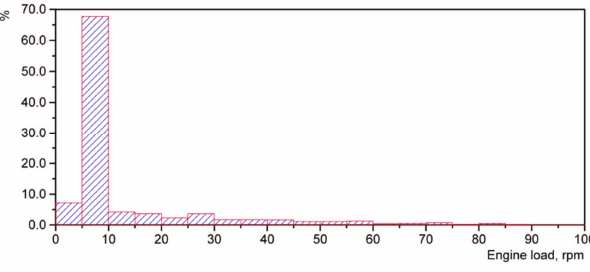
Fig. 7. Histogram of the engine load for urban traffic